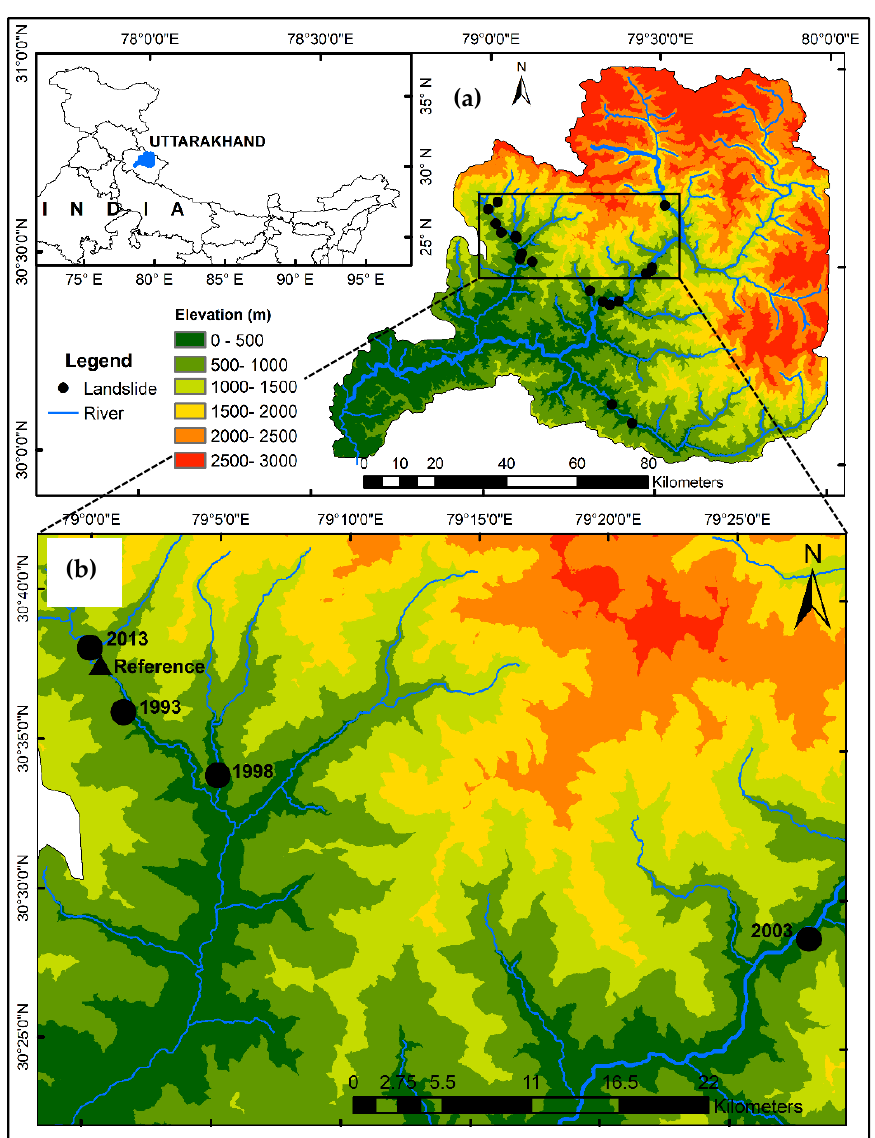
Figure 1. Topography of Alaknanda watershed. ( a ) Illustrated watershed region showing Alaknanda River (blue); black features (circles) represent the landslide sites. The black outline indicates the location of the study area. Inset map shows the geographical area of Uttarakhand state and the Alaknanda watershed (blue). ( b ) Enlarged view of the study area. Black circles represent the location of selected landslide sites with the year of occurrence. The triangle illustrates the location of the reference site.